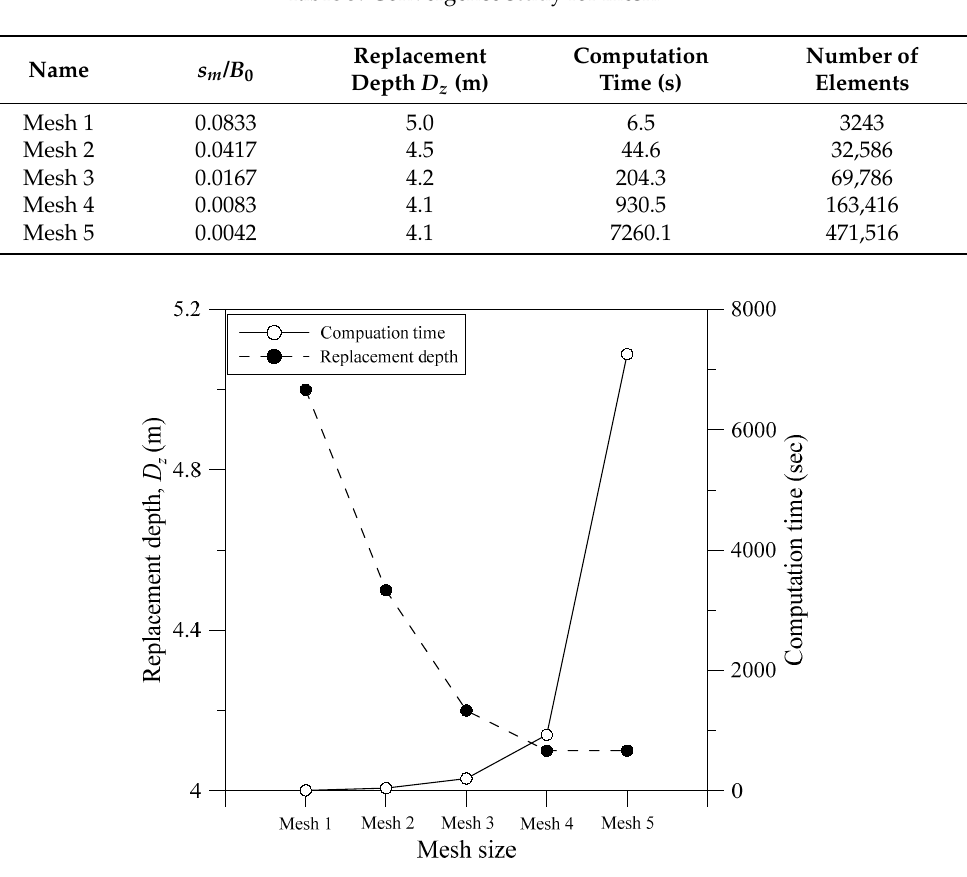
Figure 7. Relationship between replacement depth and computation time.